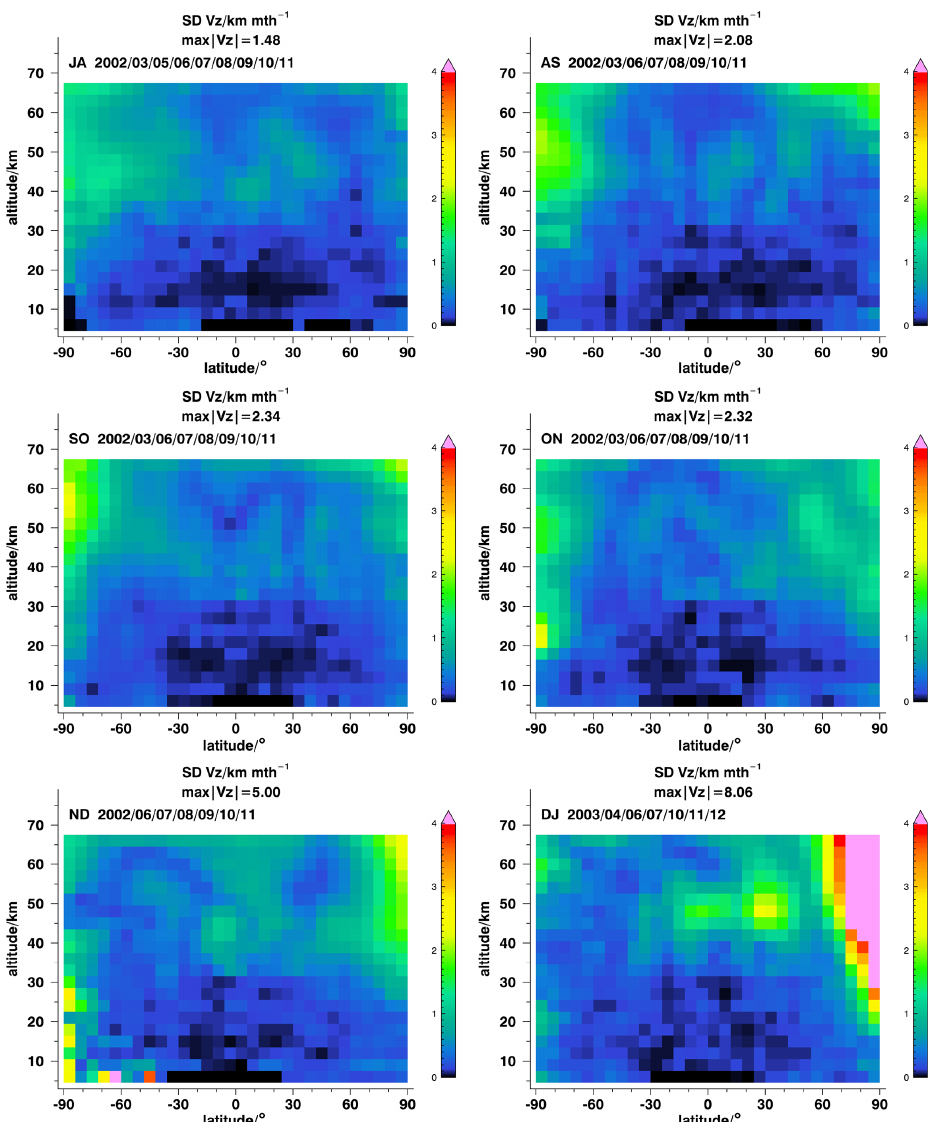
Figure 8. Interannual variability of the middle atmospheric vertical effective velocities in terms of sample standard variations from July– August (top left, JA) to December–January (bottom right,